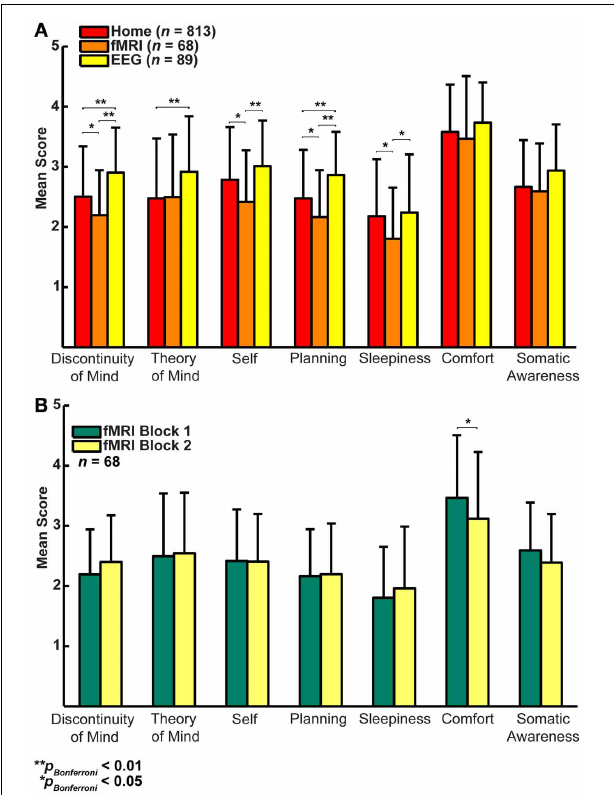
FIGURE 4 | (A) Factor score averages ( ± SD ) show that there may be substantial variability in resting-state cognition across the three groups (Home, fMRI, and EEG, t -test corrected for family relationships). (B) Only Comfortdecreasessignificantlyovertworesting-statefMRIblocksseparated by 45min ( t -test with family dependencyand Bonferroni correction, ± SD ).